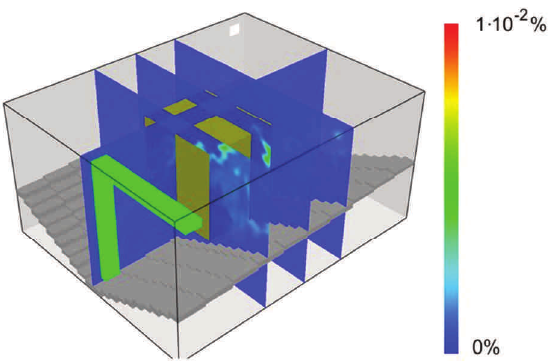
Fig. 8. DME gas accumulation in the engine compartment, leakage variant I